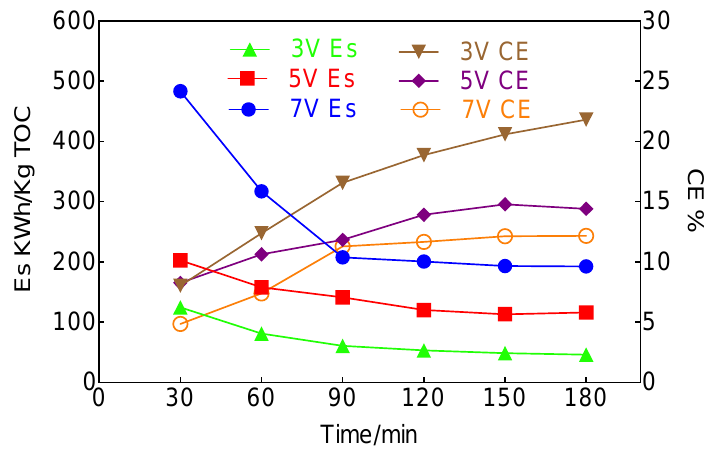
Figure 10. Es and CE of the recycling-flow 3D electro-reactor system with different voltages (RhB wastewater initial concentration is 100 mg/L; volume is 500 mL; initial pH is 7; Na 2 SO 4 as an electrolyte, initial concentration is 2 g/L; HRT is 20 min; current density is 60 mA/cm 2 ).